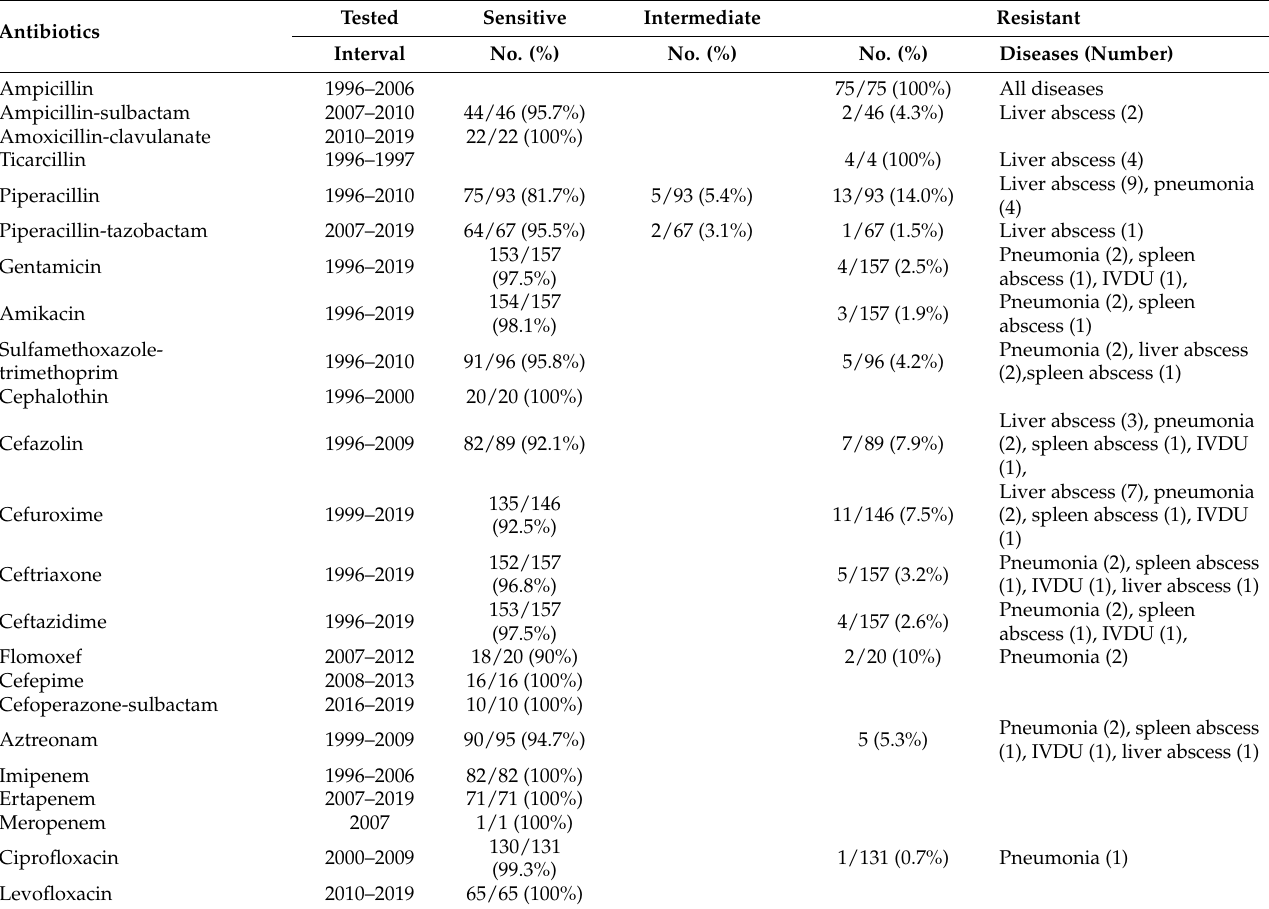
Table 3. Antibiotic susceptibility of Klebsiella pneumoniae